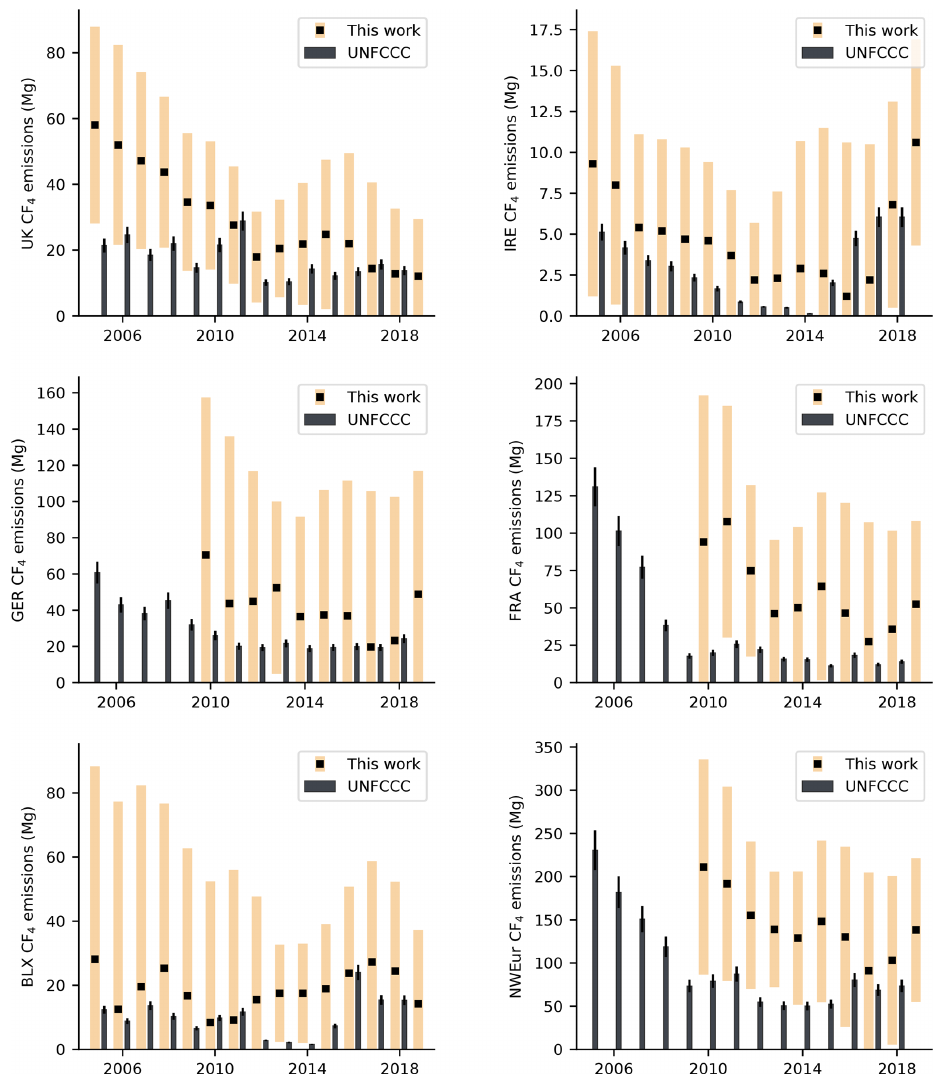
Figure 5. Annual CF 4 emissions (2005–2019) for northwest European countries in Mgyr − 1 . InTEM estimates are shown as black squares with pale orange uncertainty bounds. Emissions reported to the UNFCCC (sum of individual reporting countries) are shown as black bars, with an assumed uncertainty (black error bars) of 10%. Note that UNFCCC data are only available up until 2018